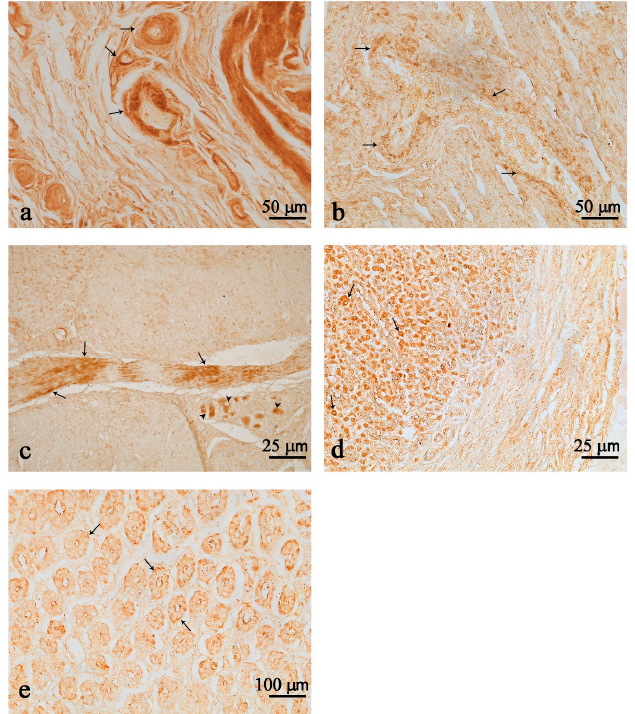
Figure 1. Nesfatin-1 (Nesf-1) immunoreactivity in the first ( a ) and second ( b , e ) chambers. Nerve fibers (arrows) in perivascular locations in the first ( a ) and second ( b ) chambers. Nesf-1 positivity in numerous fibers (arrows) and few clustered immunopositive neurons of the second chamber ( c ) (arrow heads). Positive cells in the mucosal epithelium of the second chamber (arrows) ( d – e ). Positive fibers in the submucosal layer ( d ). Scale bar: ( a , b ) = 50 µm; ( c , d ) = 25 µm; ( e ) = 100 µm. In the third chamber, immunoreactive (ir) nerve fibers were found scattered and clus- tered in the myenteric plexuses (Figure 2a–c). Many strongly immunostained neurons were found scattered or isolated (Figure 2c), but most often they were clustered and be- longed to ganglion structures (Figure 2a,b). The presence of few Nesf-1 ir-cells was de- tected in the mucosal epithelium of the third chamber (Figure 2d).